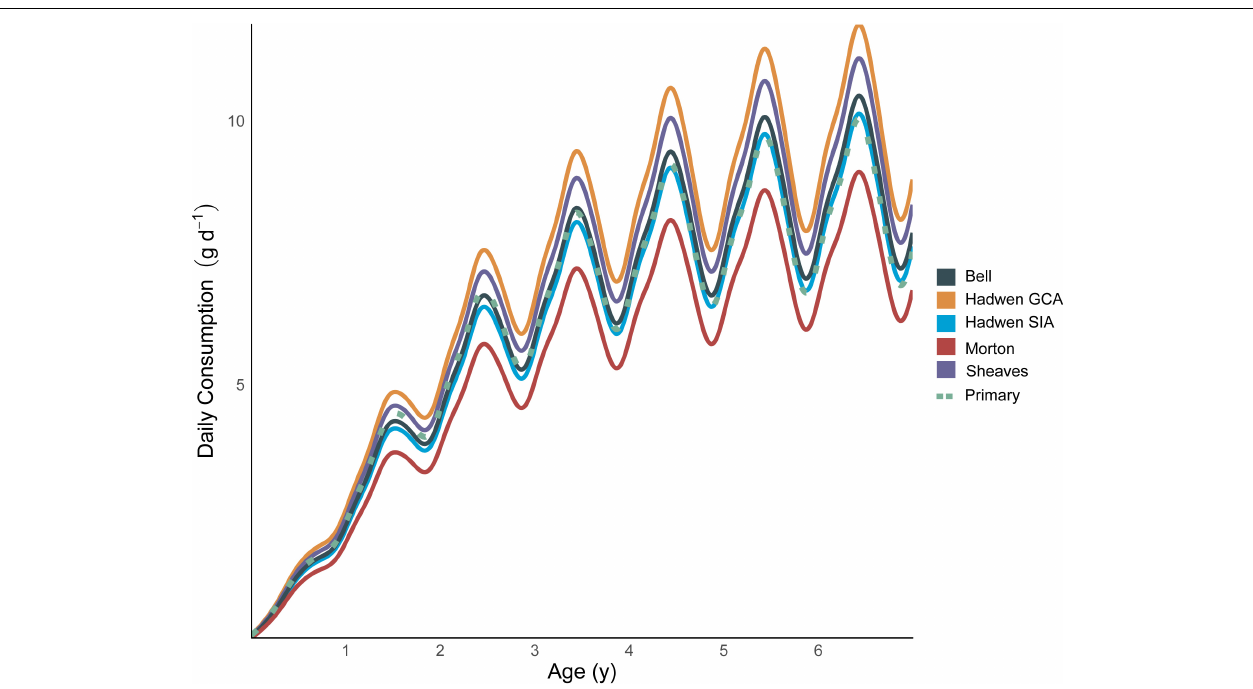
FIGURE 4 | Daily consumption rate throughout Yellowfin Bream ontogeny calculated from bioenergetic models using different prey data. Differences in consumption arise from different energy densities of the prey observed in each study. Oscillations are caused by seasonal fluctuations in water temperature and its subsequent impact on standard metabolic rate. Each model scenario was calculated using the same bioenergetic parameters, but each using different sources of dietary data (and hence prey energy density): “Bell” used the mean of 160 gut contents samples from a tidal mangrove creek, “Hadwen GCA” used the mean of 13 gut contents from intermittently open estuaries, “Hadwen SIA” used the mean of 14 muscle stable isotope samples from intermittently open estuaries, “Morton” used the mean of 187 gut content samples from mangrove/tidal salt marsh habitat, “Sheaves” used the mean of 134 gut content samples from mangrove habitat, and “Primary” included detailed ontogenetic diet variation from 1,130 gut content samples (see main text for details). For clarity, only five of the nine comparative scenarios are plotted here. See Tables 3 , 4 for results from all nine comparative scenarios.